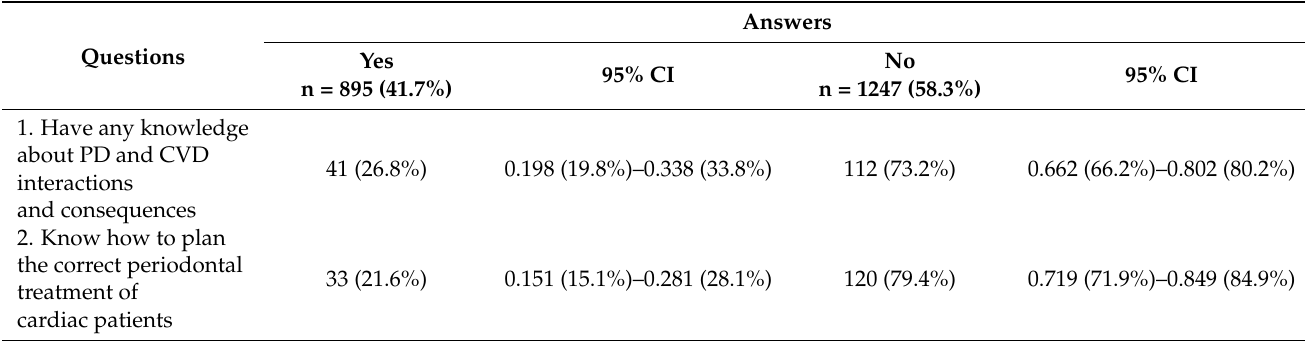
Table 2. Technical knowledge of DUS about cardiac patient